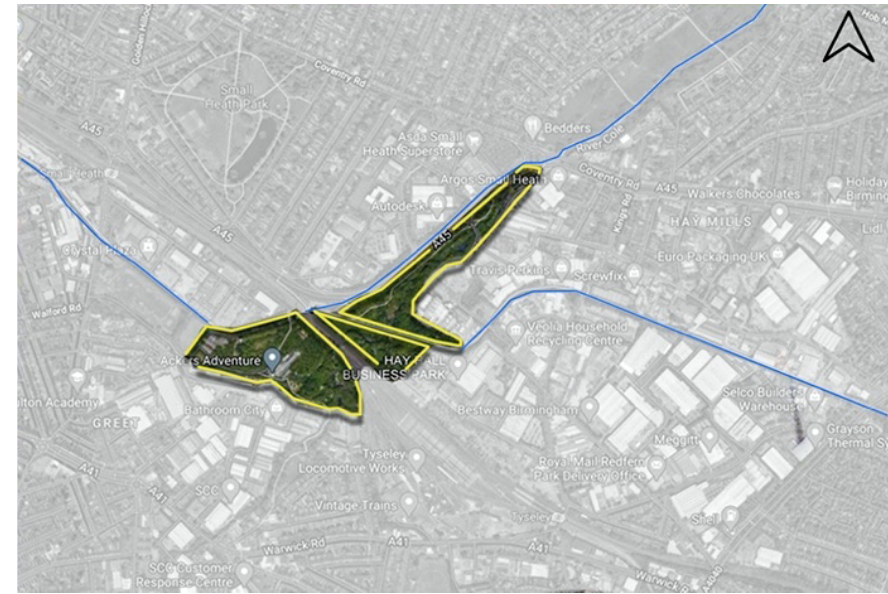
Figure 3. The Lost World showing the Grand Union Canal (running ~E-W) and the River Cole (running ~SE-NW). October 2019 to explore what The Lost World might